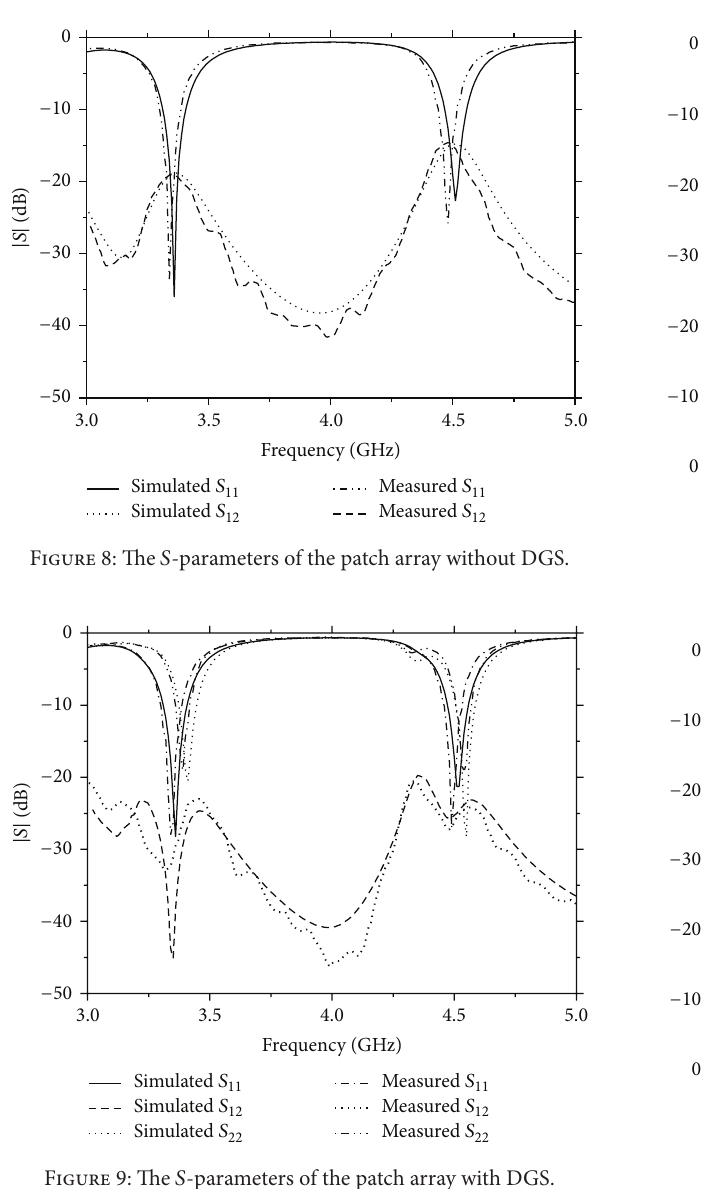
Figure 9: The 𝑆 -parameters of the patch array with DGS.